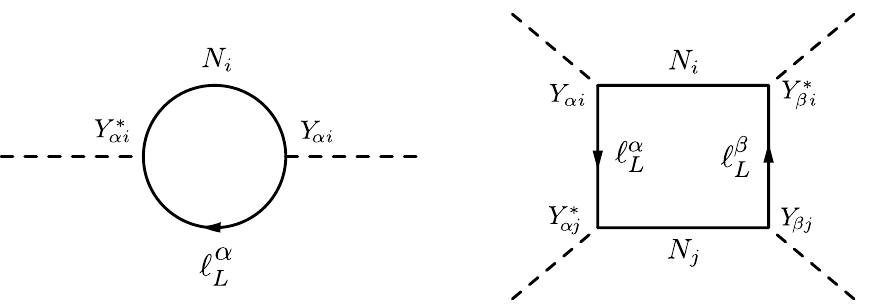
Figure 1 . The dominant one-loop contribution generating the Higgs potential in the type-I seesaw model. Here ‘ (cid:11) denotes the SU(2) lepton doublet, as the EW symmetry is unbroken at this L